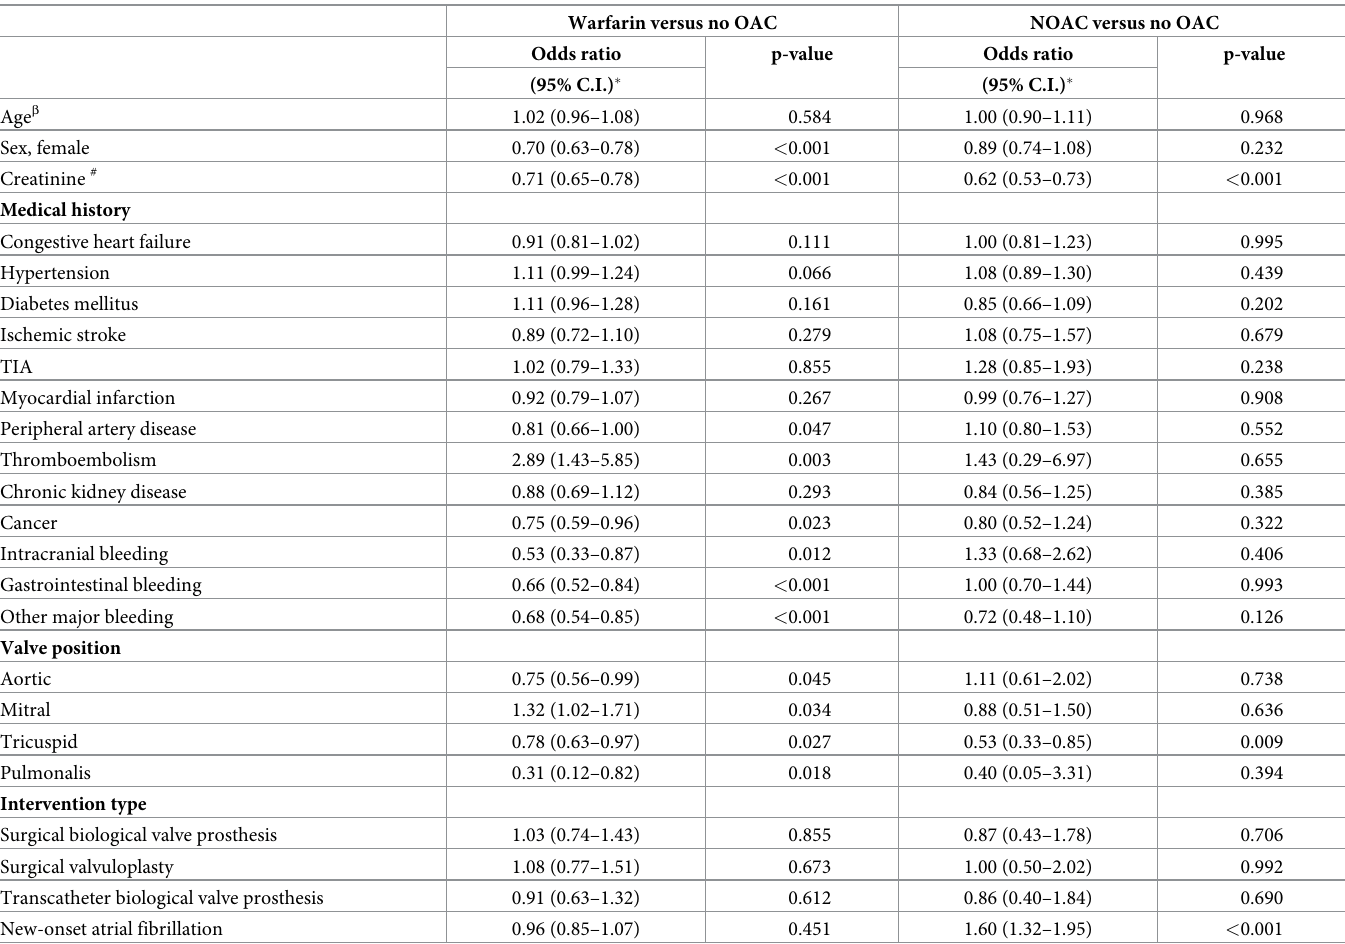
Table 4. Independent predictors of treatment with OAC versus no treatment with oral anticoagulants.